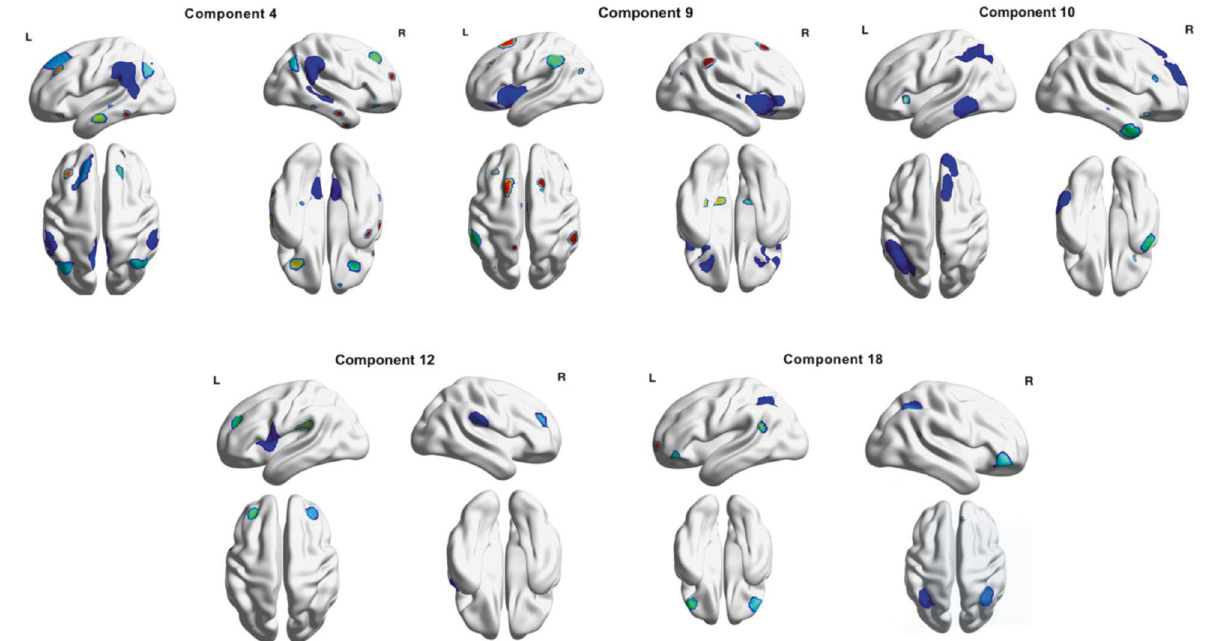
Fig. 2 The components in the dataset which correspond to the three networks of interest. IC 4 consisted of the posterior DMN regions and also anterior regions such as the anterior cingulate gyrus and frontal pole. IC 9 was comprised of regions relating to the SN such as the paracingulate gyrus, insular cortex and frontal orbital cortex. IC 10 consisted of regions relating to the FPN such as the frontal pole, middle frontal gyrus, middle temporal gyrus and other regions such as the cerebellum. IC 12 was comprised of SN regions such as the insular cortex and other regions such as the frontal operculum cortex and precentral gyrus. IC 18 consisted mainly of regions that are speci fi c to the posterior portion of the DMN such as the posterior cingulate gyrus and precuneus.